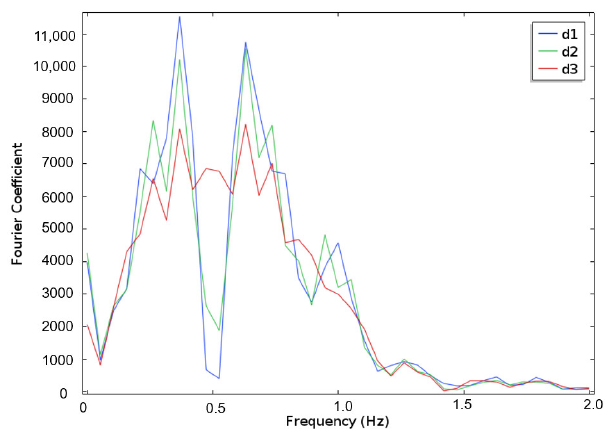
Figure 9. ( a ) Pressure distribution contour in the honeycomb microchannel, Pa; ( b ) Pressure fluctu- ation of point C with time under different working conditions.